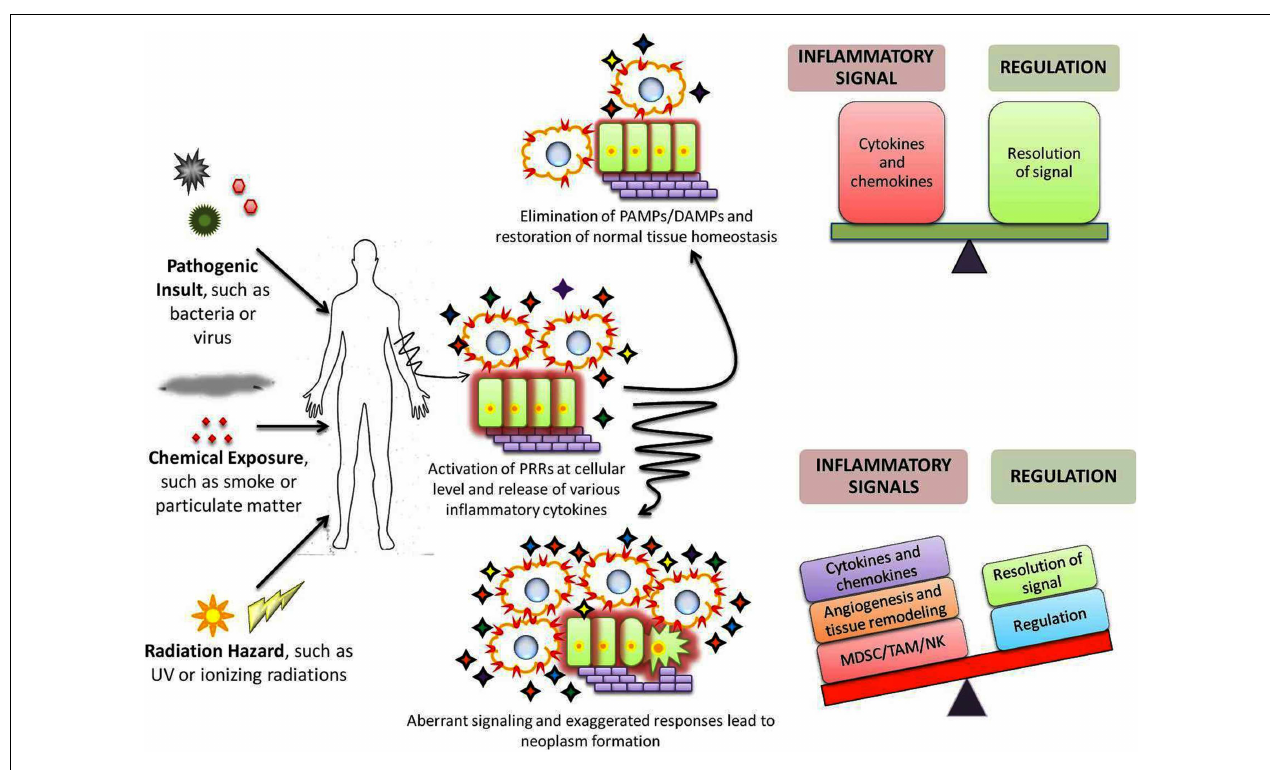
certain circumstances, the precise balance is altered due to aberrant/exaggerated inflammation or failure of regulatory mechanisms to restrict them. Such imbalance results in accumulation of cells and chemicals that deregulate the proliferative pathways; induce angiogenesis and damage the extracellular matrix, thus aiding in origin and/or progression of